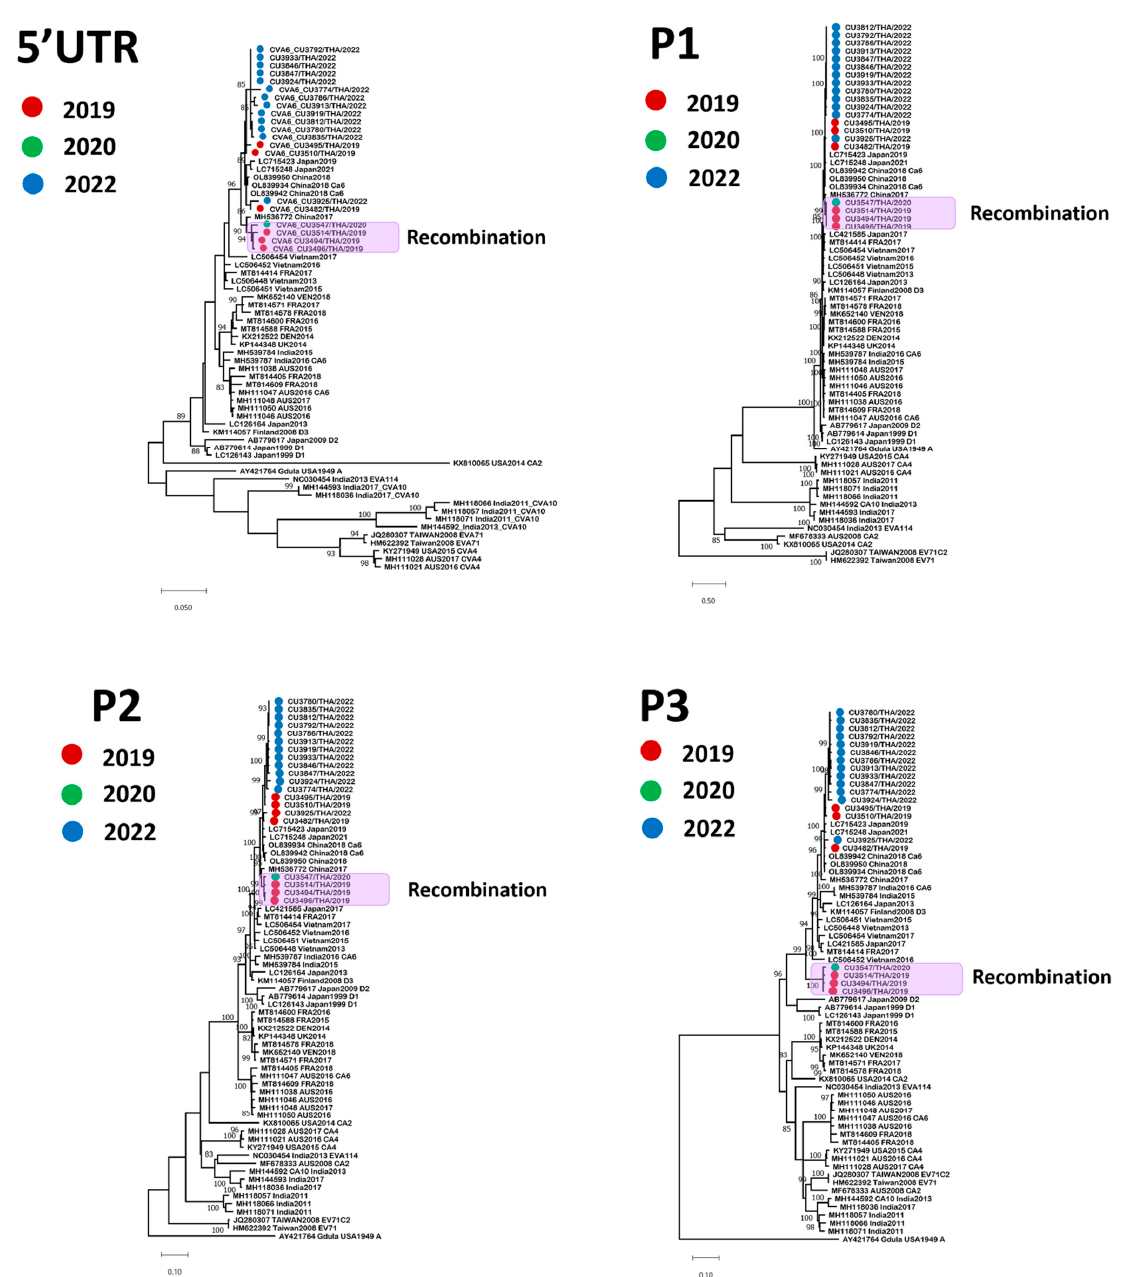
Figure 3. Unrooted phylogenetic trees of coxsackievirus (CV)-A6 strains based on different genomic regions. Maximum-likelihood trees were constructed based on the 5 ′ -UTR and the P1, P2, and 3Dpol regions. Sequences are numbered according to the numbering of the Gdula prototype strain (GenBank accession number AY421764) and previously referenced sequences. Bootstrap values at key nodes are shown as percentages of 1000 replicates. The nearly complete genome sequences of the 20 CV-A6/TH strains, obtained in this study, are highlighted using colored dots. The scale bars represent the number of substitutions per site.